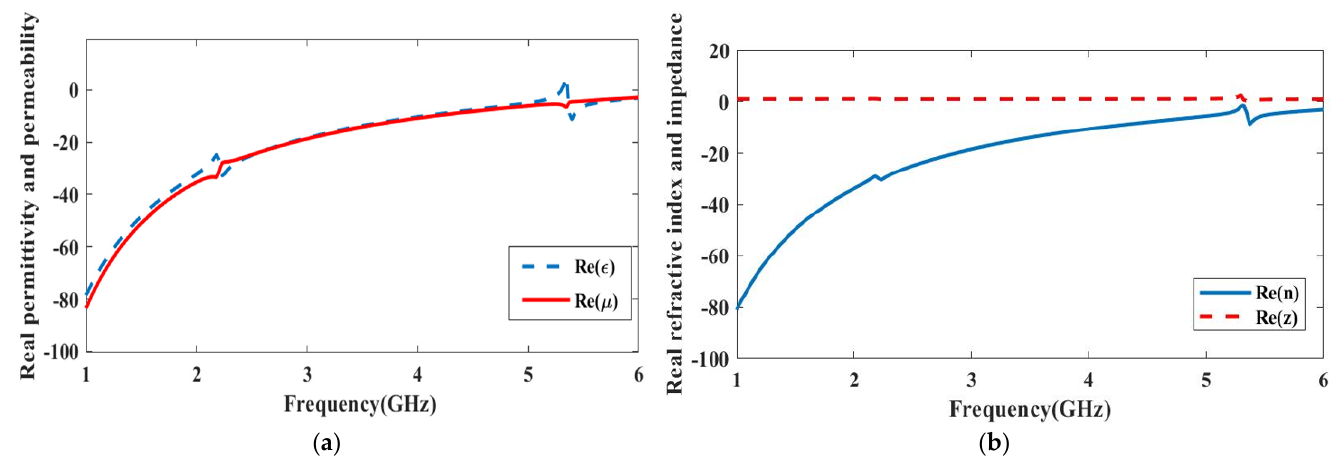
Figure 5. Retrieved results for: ( a ) relative permittivity ɛ and relative permeability µ ; ( b ) refractive index n and impedance z.